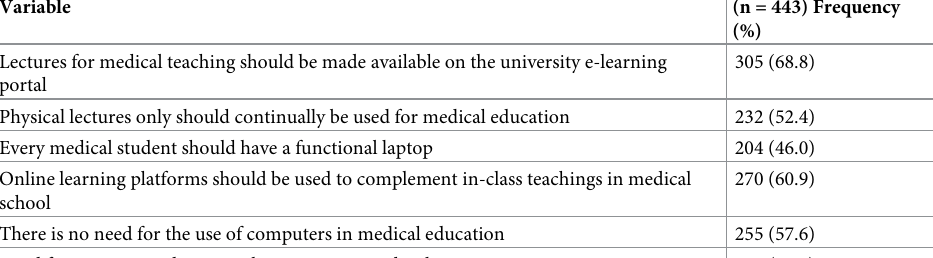
Table 5. Attitude towards information & communication technology (ICT) based medical education. Variable